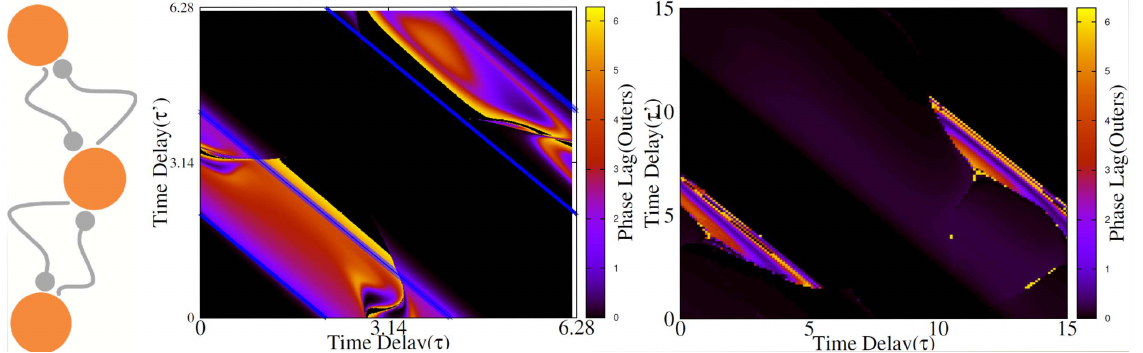
Fig. 10. Symmetric variation of the delay times. In the left panel the phase lag of outer neurons in a relay system with canonical type-II oscillators. Horizontal and vertical axes show the incoming and outgoing delay times, respectively. Solid lines show the boundary of stable synchrony. The similar results are shown for HH neurons in the